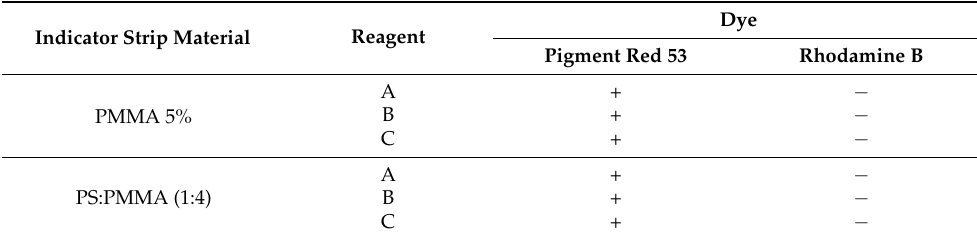
Table 3. Results of the selectivity test of indicator strips from the PMMA and PS:PMMA mixtures using the reagent blending method.